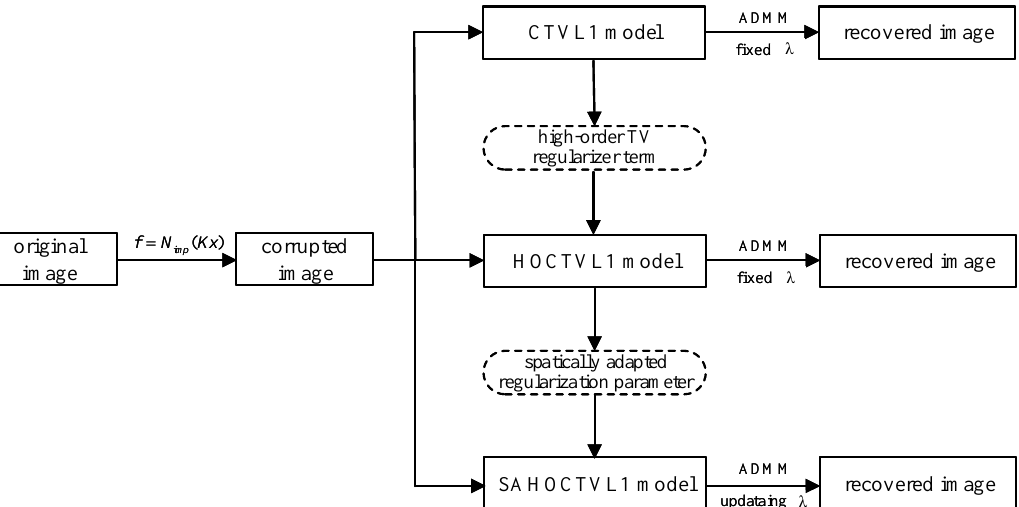
Figure 1. The block diagram of solving image deblurring problem under impulse